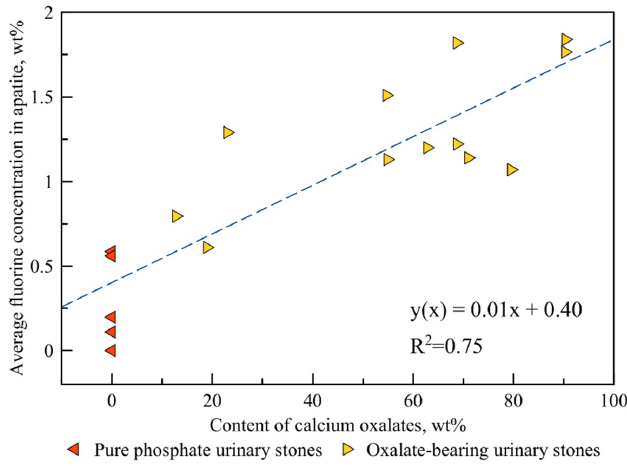
Figure 9. Direct correlation between the amount of oxalate mineral phases (wt%) and the fluorine content (wt%) in the stone.